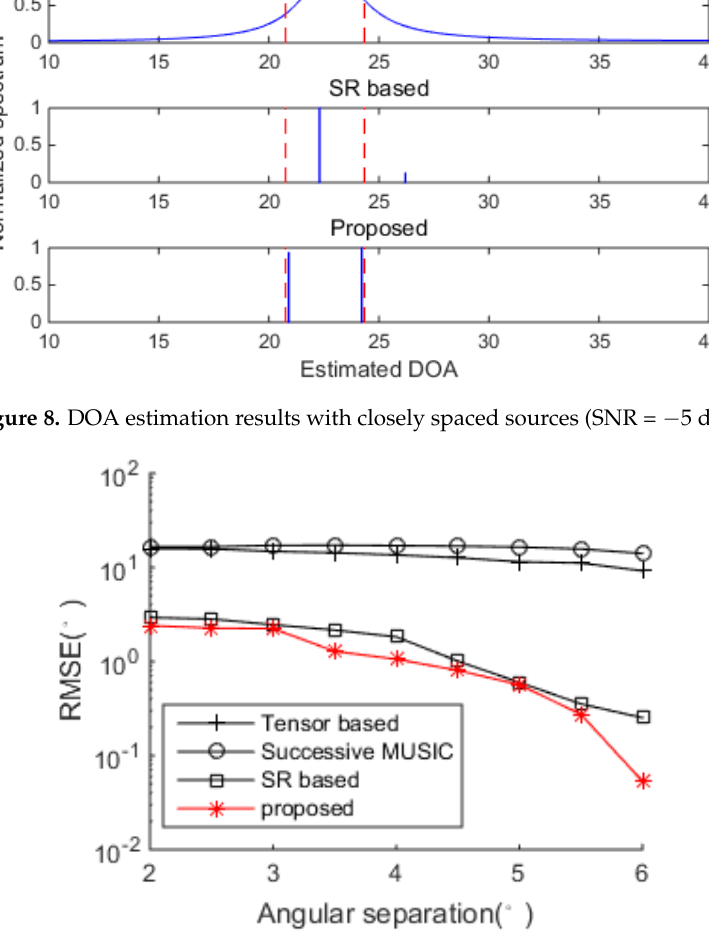
Figure 8. DOA estimation results with closely spaced sources (SNR = − 5